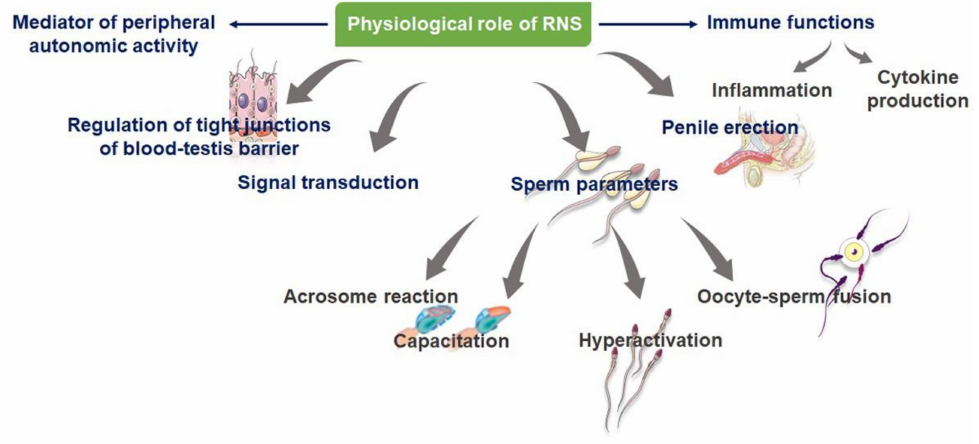
Figure 2. Physiological role of reactive nitrogen species (RNS). The figure shows the essential role RNS play in the human body. At physiological levels, RNS help to stimulate the immune system, maintain normal sperm parameters, and carry out general reproductive functions in the male